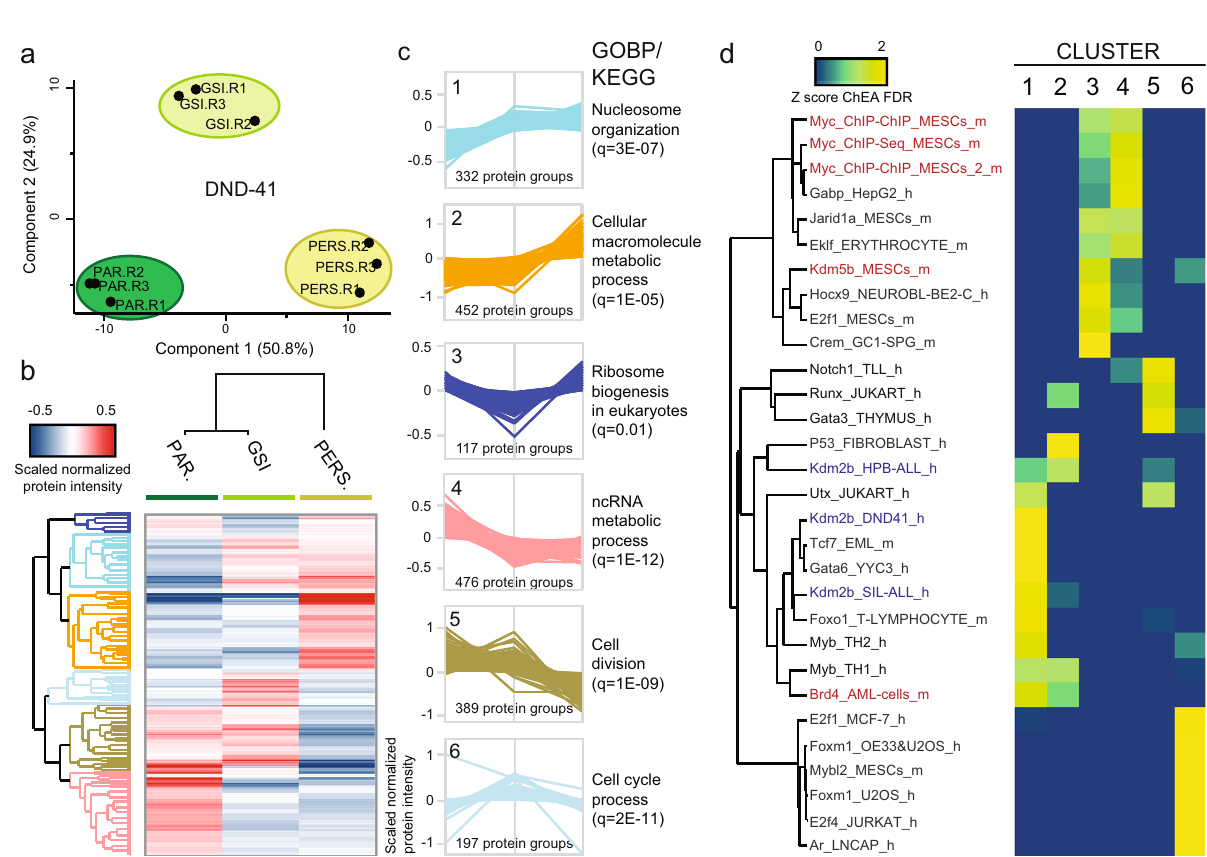
Fig. 3 Proteomics analysis of drug-tolerant persister DND-41 cells. a Principal component analysis (PCA) of all quanti fi ed proteins. b Hierarchical clustering of normalized protein intensities scaled per replicate (columns: Pearson correlation; rows: Canberra distance) for signi fi cantly regulated proteins among conditions (one-way ANOVA: Benjamini – Hochberg FDR = 0.01; s0 = 0.1; n = 3 biologically independent samples). The mean for each protein per condition is shown. c Protein expression pro fi les for each cluster are shown on the left. The most enriched gene ontology term per cluster is shown on the right side of each pro fi le. Enrichment analysis was performed in Perseus using all regulated proteins per cluster (background: proteome). d Regulated proteins were ranked based on the log2 fold-change Persister/Parental (Cluster 1 – 2 and 4 – 5) or Persister/GSI (Cluster 3 and 6) and ChIP enrichment analysis (ChEA) was performed with the top-100 through Enrichr. The − log10 of the Benjamini – Hochberg corrected p values (FDR) are Z-score normalized and the results are shown in a heatmap. PAR parental, PERS persister, GOBP gene ontology biological processes, q Benjamini – Hochberg-corrected p value, h human, m murine. Source data are provided as Source Data fi